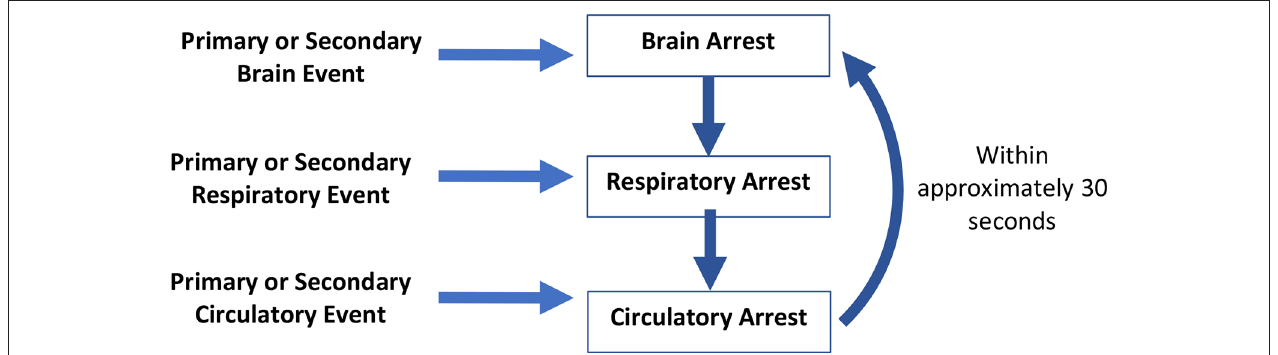
figuRe 1 | Mechanisms which might precipitate organ arrest and the dying